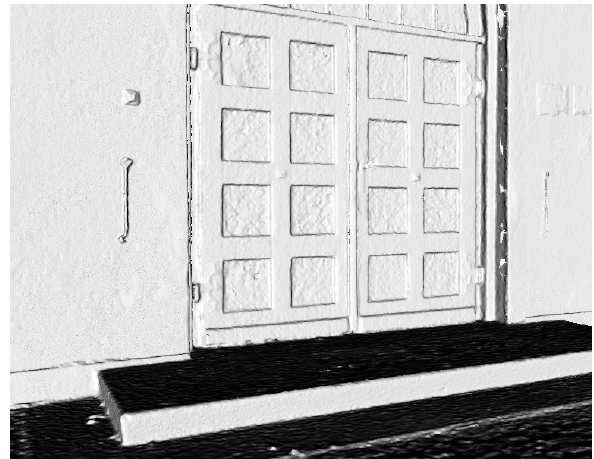
Figure 5: Dense 3D reconstruction of a small part of the scene shown in Fig.